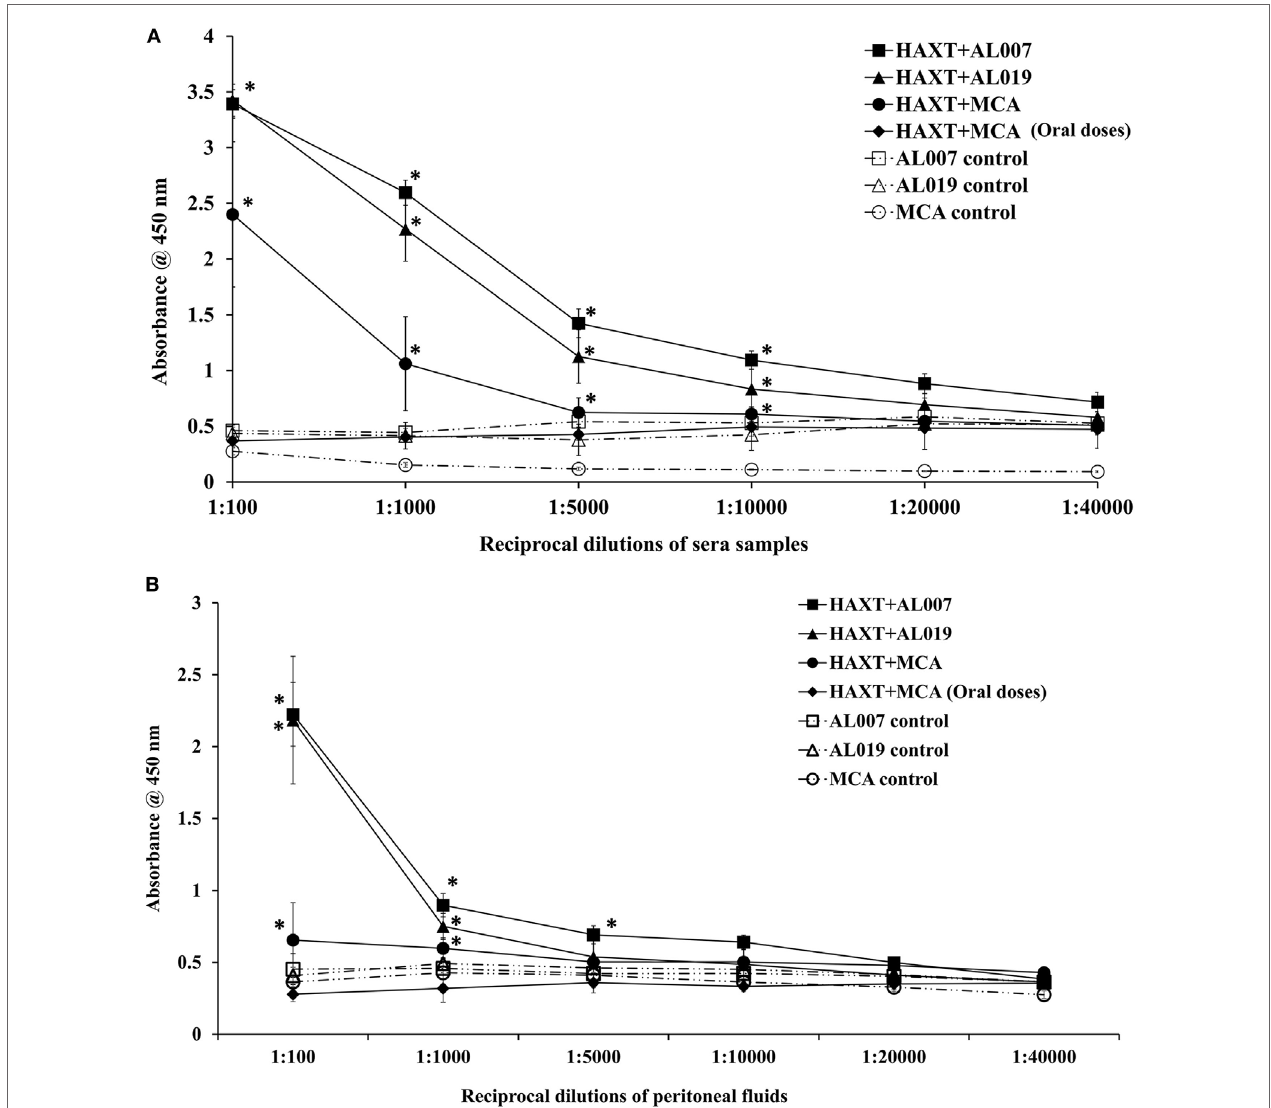
FigUre 2 | Titer of r Bm HAXT-specific IgG antibodies in immunized animals. (a) r Bm HAXT-specific IgG titer in sera samples showed that both AL007 and AL019 adjuvants-based formulations are better in generating the IgG titer (1:20,000) when compared to mannosylated chitosan (MCA) formulations (1:10,000). Pre- immune sera samples were used as baseline controls in these assays. (B) In peritoneal fluid, titer of IgG is comparatively low (1:10,000) in AL007 and AL019- based formulations when compared to sera samples. In contrast, IgG titer is significantly reduced in r Bm HAXT + MCA-treated animal’s peritoneal fluid than sera samples. n = 5 per group, * p < 0.05 compared to respective group as analyzed by Kruskal–Wallis test followed by Bonferroni correction for multiple